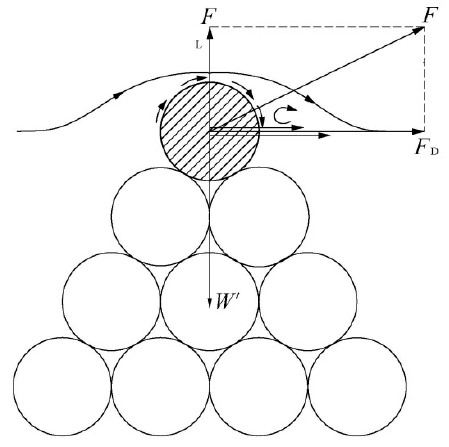
Figure 8. Schematic diagram of forces acting on particles.